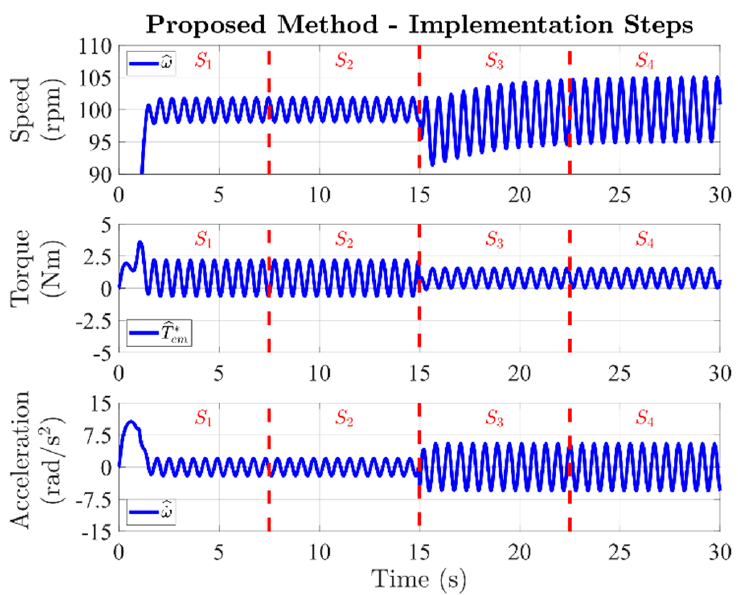
Figure 16. Implementation steps of the proposed method (the speed transient from 0 to 100 rpm is not fully shown to better emphasize the drum speed oscillations).